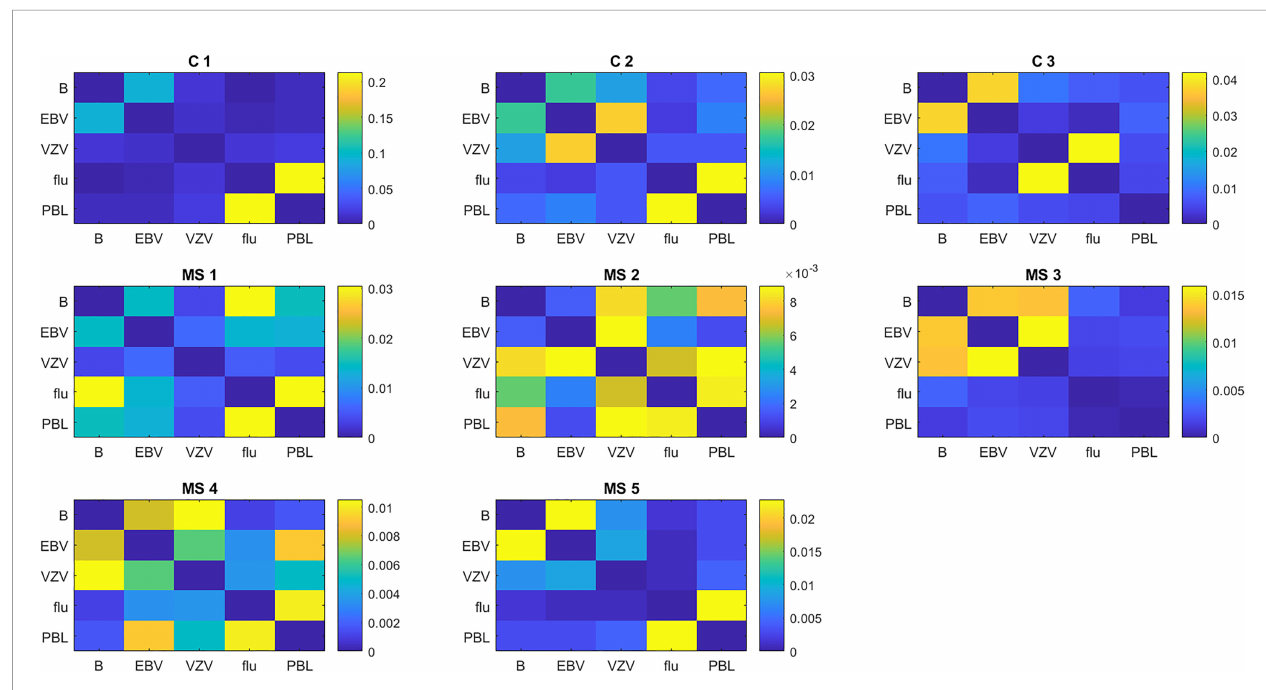
FIGURE 6 | Similarity of the TCR repertoire to different antigens in individual subjects. Similarity is calculated as the weighted Jaccard